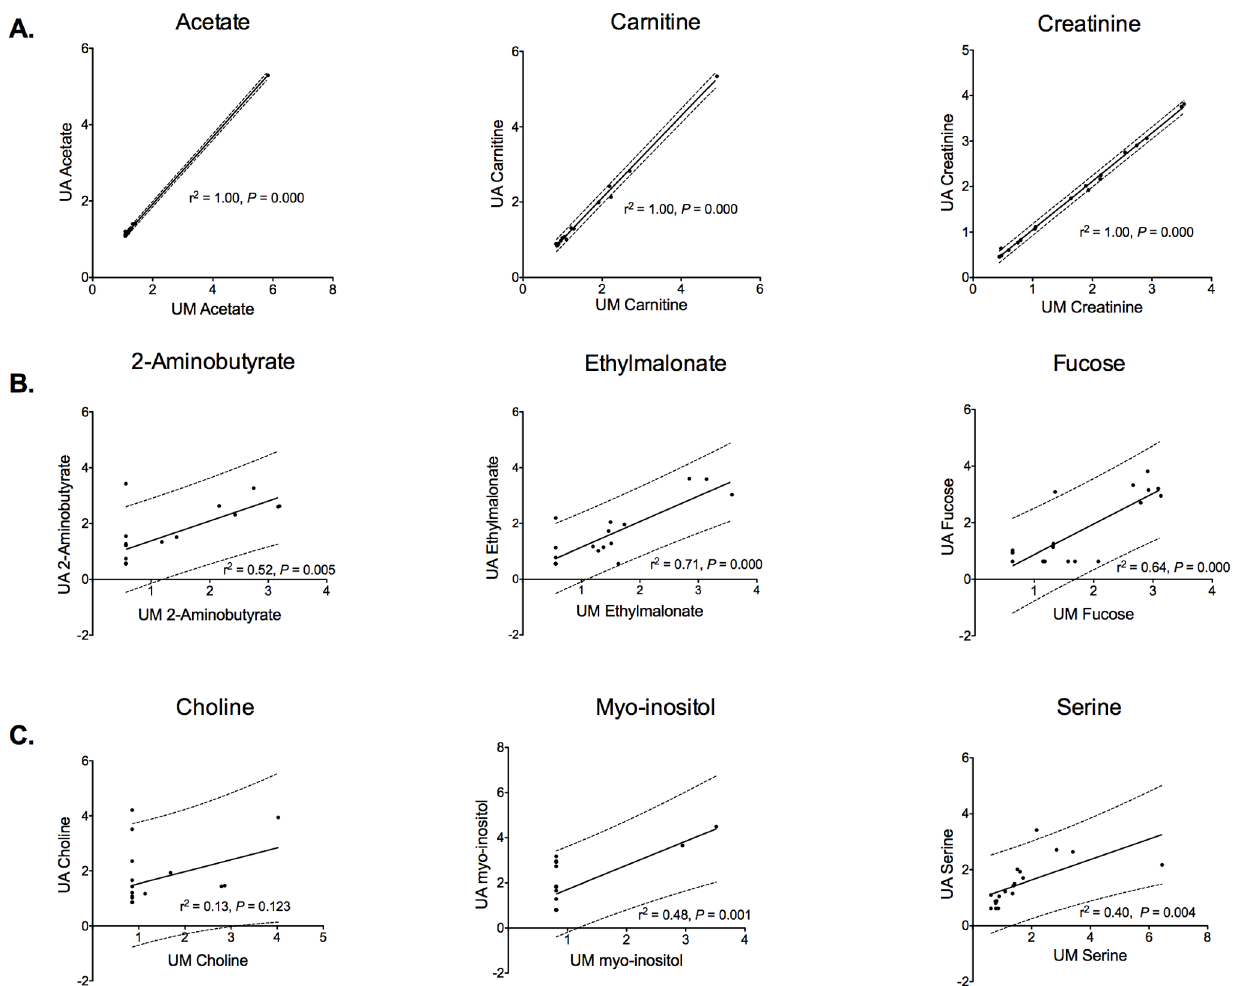
Figure 2. Representative Pearson linear regression plots with associated 95% prediction bands (dashed lines) of selected urine metabolites (normalized data). These data show: ( A ) a high degree of correlation (r 2 =1.0), acetate, carnitine, and creatinine; ( B ) a moderate degree of correlation (r 2 $ 0.5, , 0.9), 2-aminobutyrate, ethylmalonate, and fucose; and ( C ) a low degree of correlation (r 2 , 0.5), choline, myo-inositol, and serine. All data shown are from 1 H-NMR spectra acquired from technical replicate samples using 5 mm probes at the University of Alberta (UA) and the University of Michigan (UM). In all cases, the correlation p value was significant with the exception of choline (p=0.123).